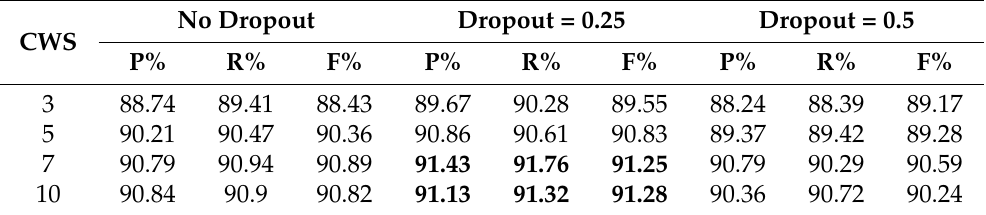
Table 6. The impact of context (length of CWS) and various dropout rates for the CaBiLSTM model on the SiNER test set using the contextual representation learning approach. The bold results highlight the best